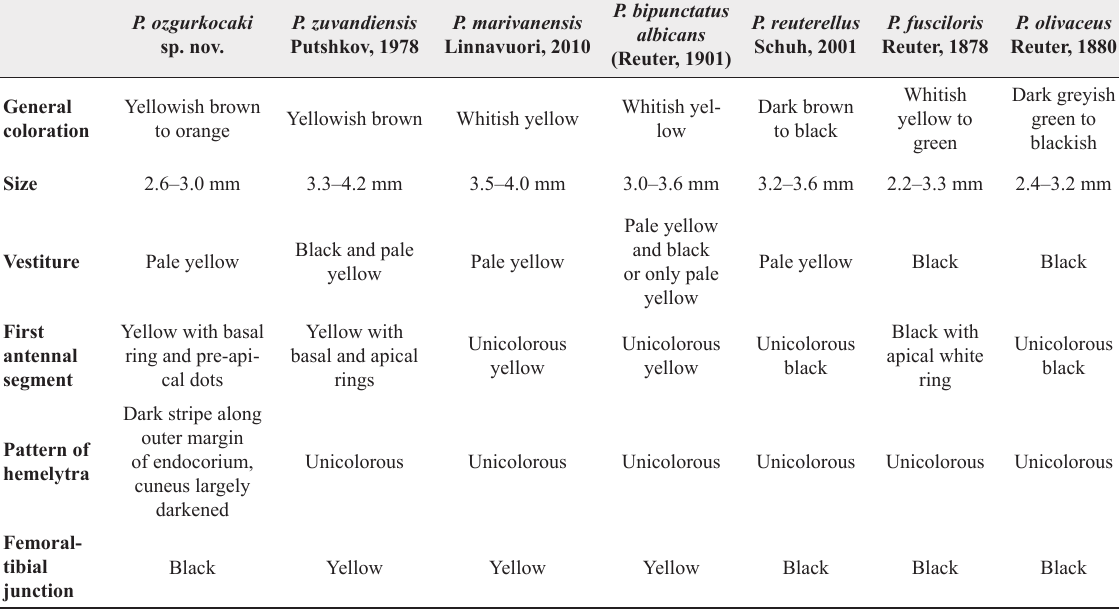
Table 1. Characteristic features of Plagiognathus ozgurkocaki sp. nov. and similar congeners [Information about other species is based on (Wagner 1975; Putshkov 1978; Linnavuori 2010; Pagola- Carte